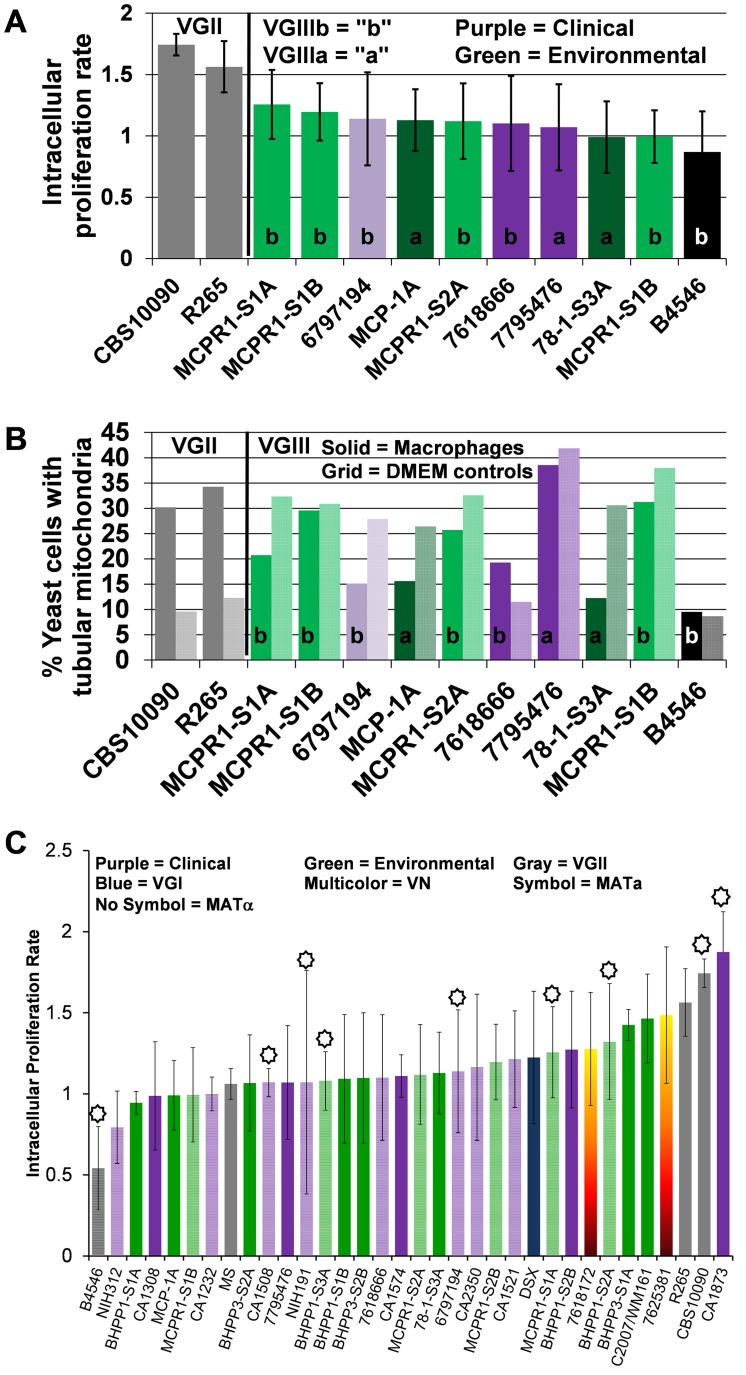
Intracellular proliferation rates (IPR) illustrate moderate proliferation levels and suggest mitochondrial tubularization is decoupled from IPR in macrophages for C. gattii VGIII isolates.(A) Intracellular C. gattii proliferation rates in macrophages were similar between environmental and clinical isolates. (B) Percent tubular mitochondria as a result of co-incubation with macrophages (solid bars) in comparison to DMEM controls (hatched bars). Percent tubular mitochondria does not correlate with IPR or virulence. Clinical isolates (VGIIIa dark-purple; VGIIIb light-purple), environmental isolates (VGIIIa dark-green; VGIIIb light-green), and previously reported isolates VGIIIa reference strain B4546 (Black) and VGII (Grey). (C) Ranked IPR of tested C. gattii isolates.